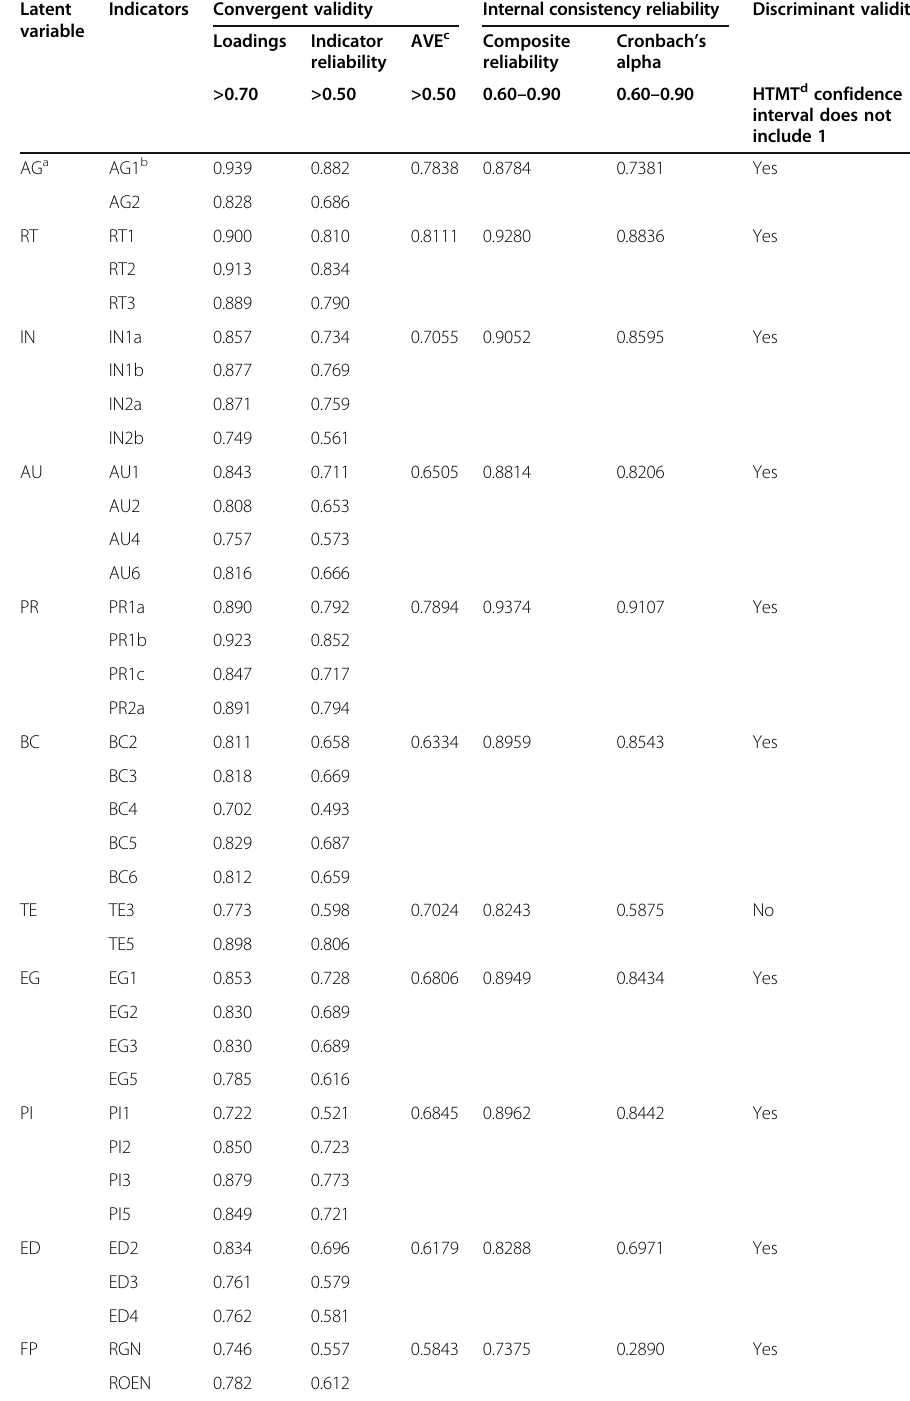
Table 4 Measurement model